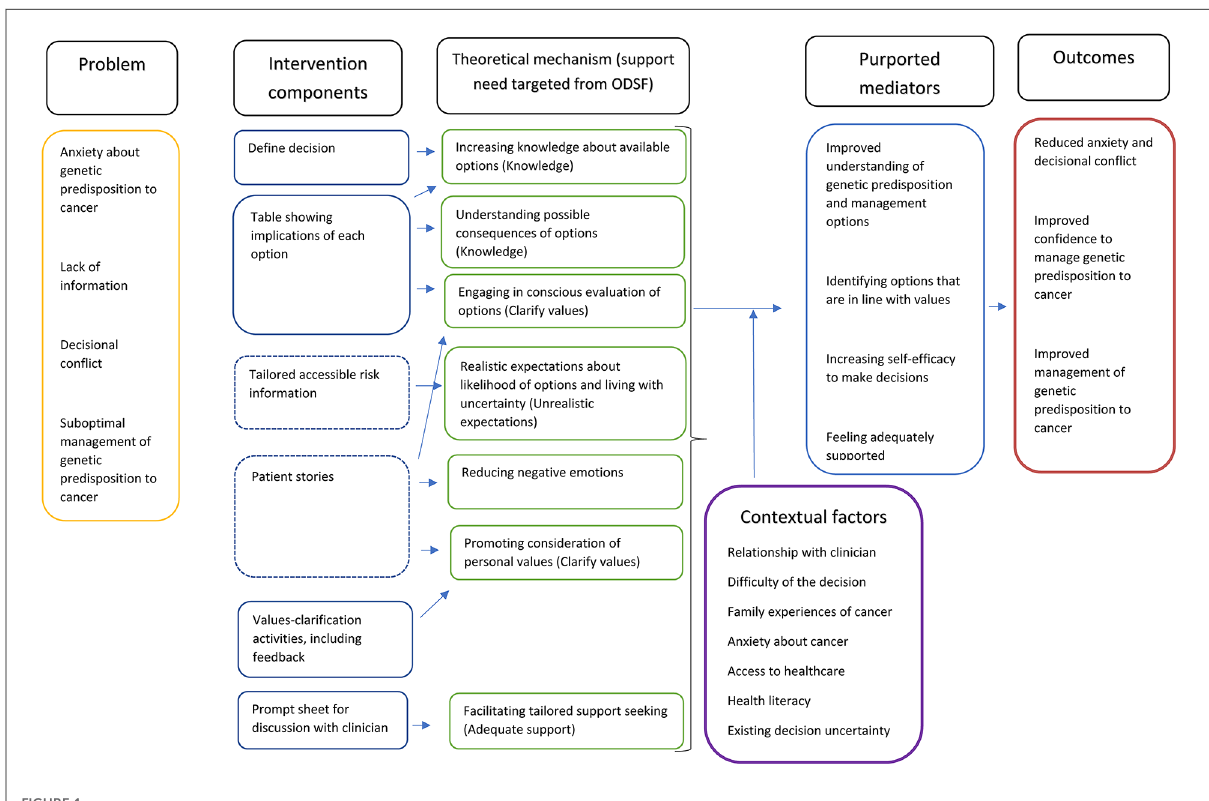
FIGURE 1 Programme theory for decision aid